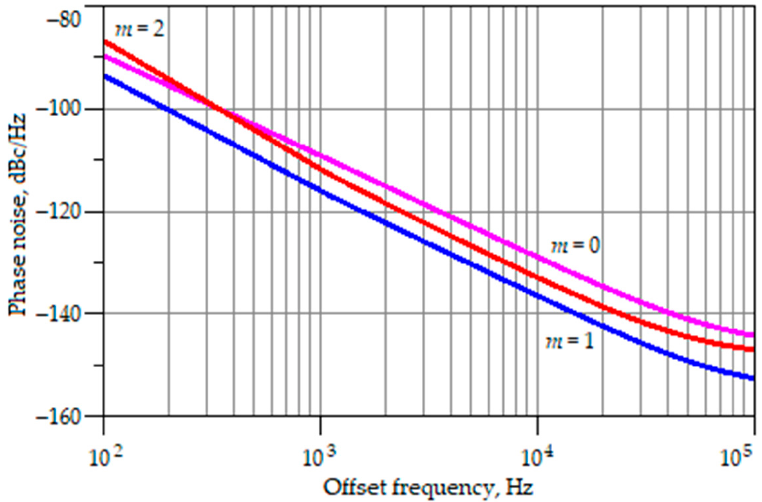
Figure 24. Phase noise versus offset frequency for VCO with multiple-output improved Wilson current mirror when V d = 12 V, R L = ∞ ; m = 0—purple curve ( C a = 10 pF), m = 1—blue curve ( C a = 7 pF), m = 2—red curve ( C a = 6 pF).